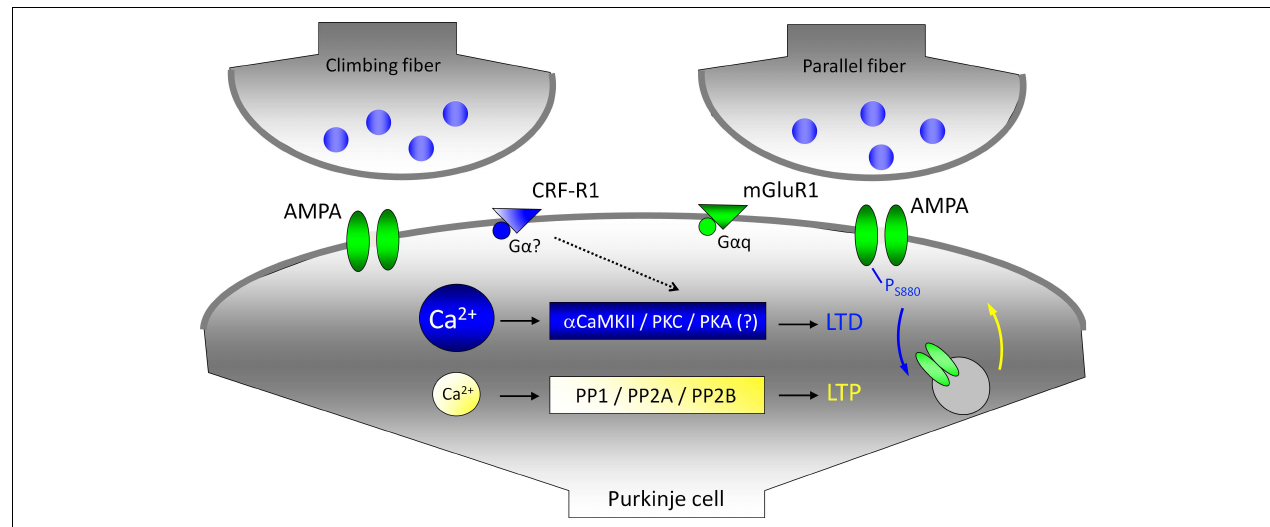
FIGURE 4 | Climbing fi ber activity facilitates LTD induction at parallel fi ber synapses. For simplicity, climbing fi ber and parallel fi ber terminals are shown to contact the same postsynaptic compartment. The LTD induction cascade is shown in blue: large calcium transients promote the activation of α CaMKII and PKC. A PKC-mediated phosphorylation of the AMPA receptor subunit GluR2 triggers the internalization of GluR2 subunits. The LTP cascade is shown in yellow: lower calcium transients promote phosphatase activation (only PP2B is